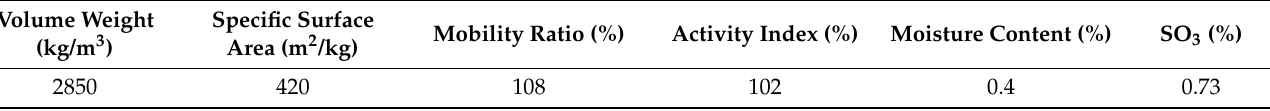
Table 2. Physical properties of